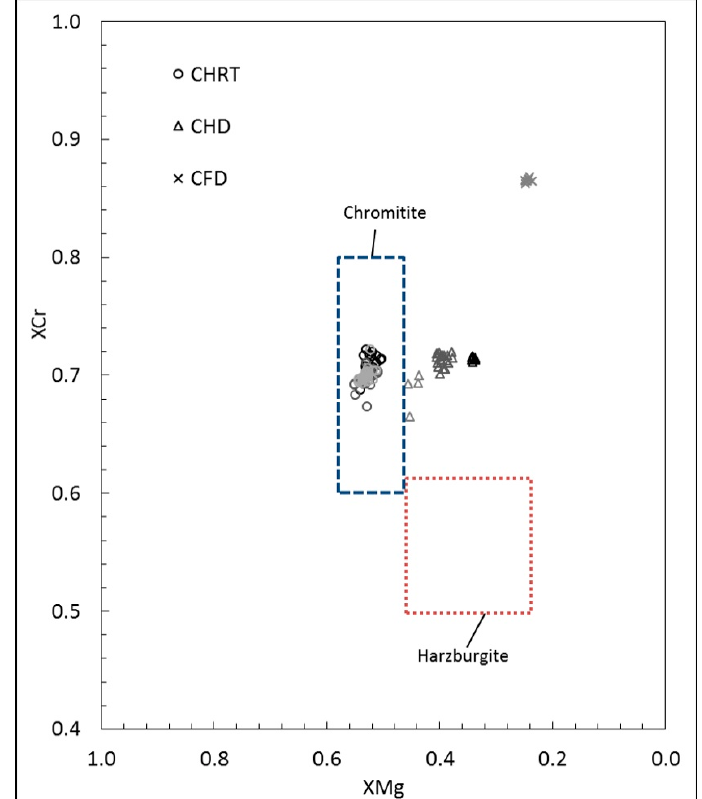
Figure 3. XCr vs. XMg values of spinels in three lithologies (CHRT: chromitite; CHD: chromitite-hosting dunite; CFD: chromitite-free dunite) compared to Finero harzburgite and chromitite compositional fields. Harzburgite data are from Grieco et al. [18]; chromitite data are from Zanetti et al. [21].